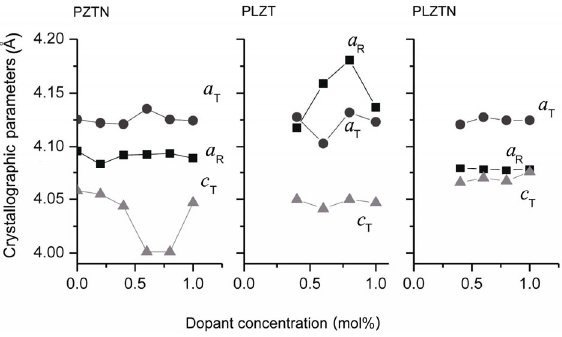
Fig. 2 Lattice parameters for different type of substitution.